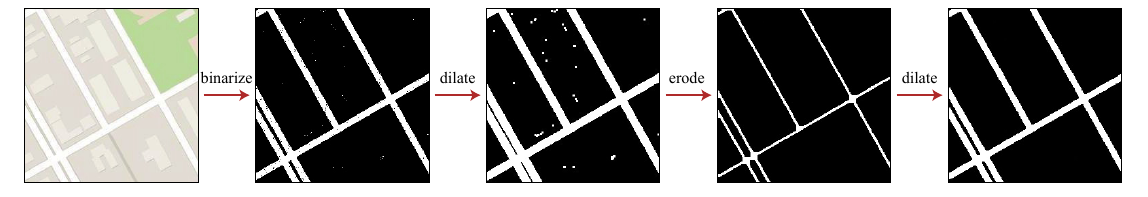
Figure 5. Schematic of post-processing.